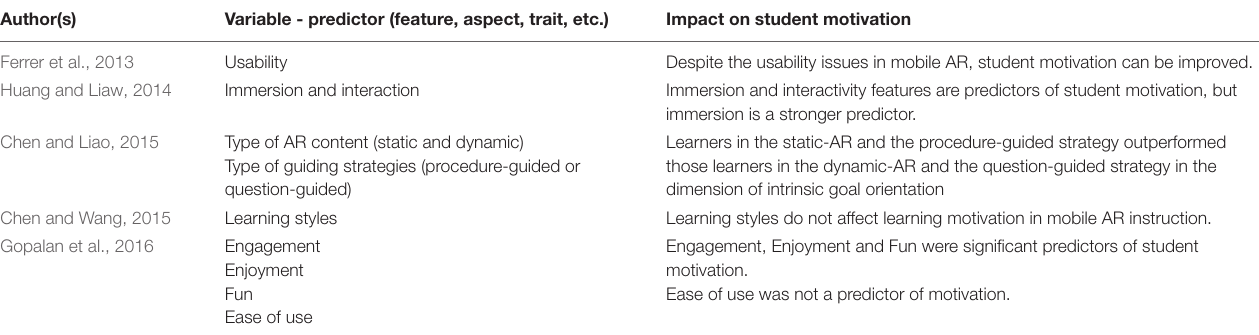
TABLE 2 | Studies that report variables that might impact on student motivation.